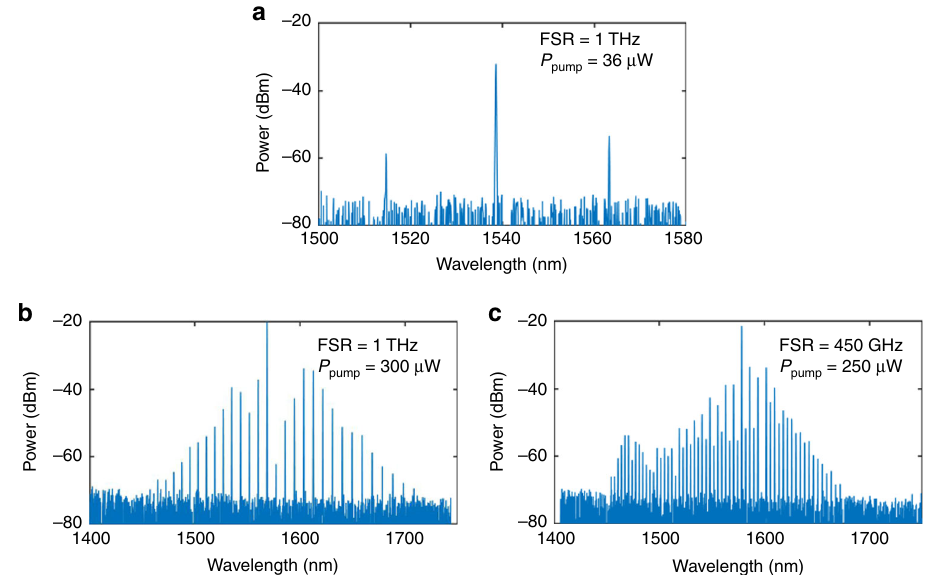
Fig. 4 Frequency-comb characterization. Spectrum generated by a 1 THz resonator under pump power of ( a ) 36 µ W and ( b ) 300 µ W, and a 450 GHz resonator under pump power of ( c ) 250 µ